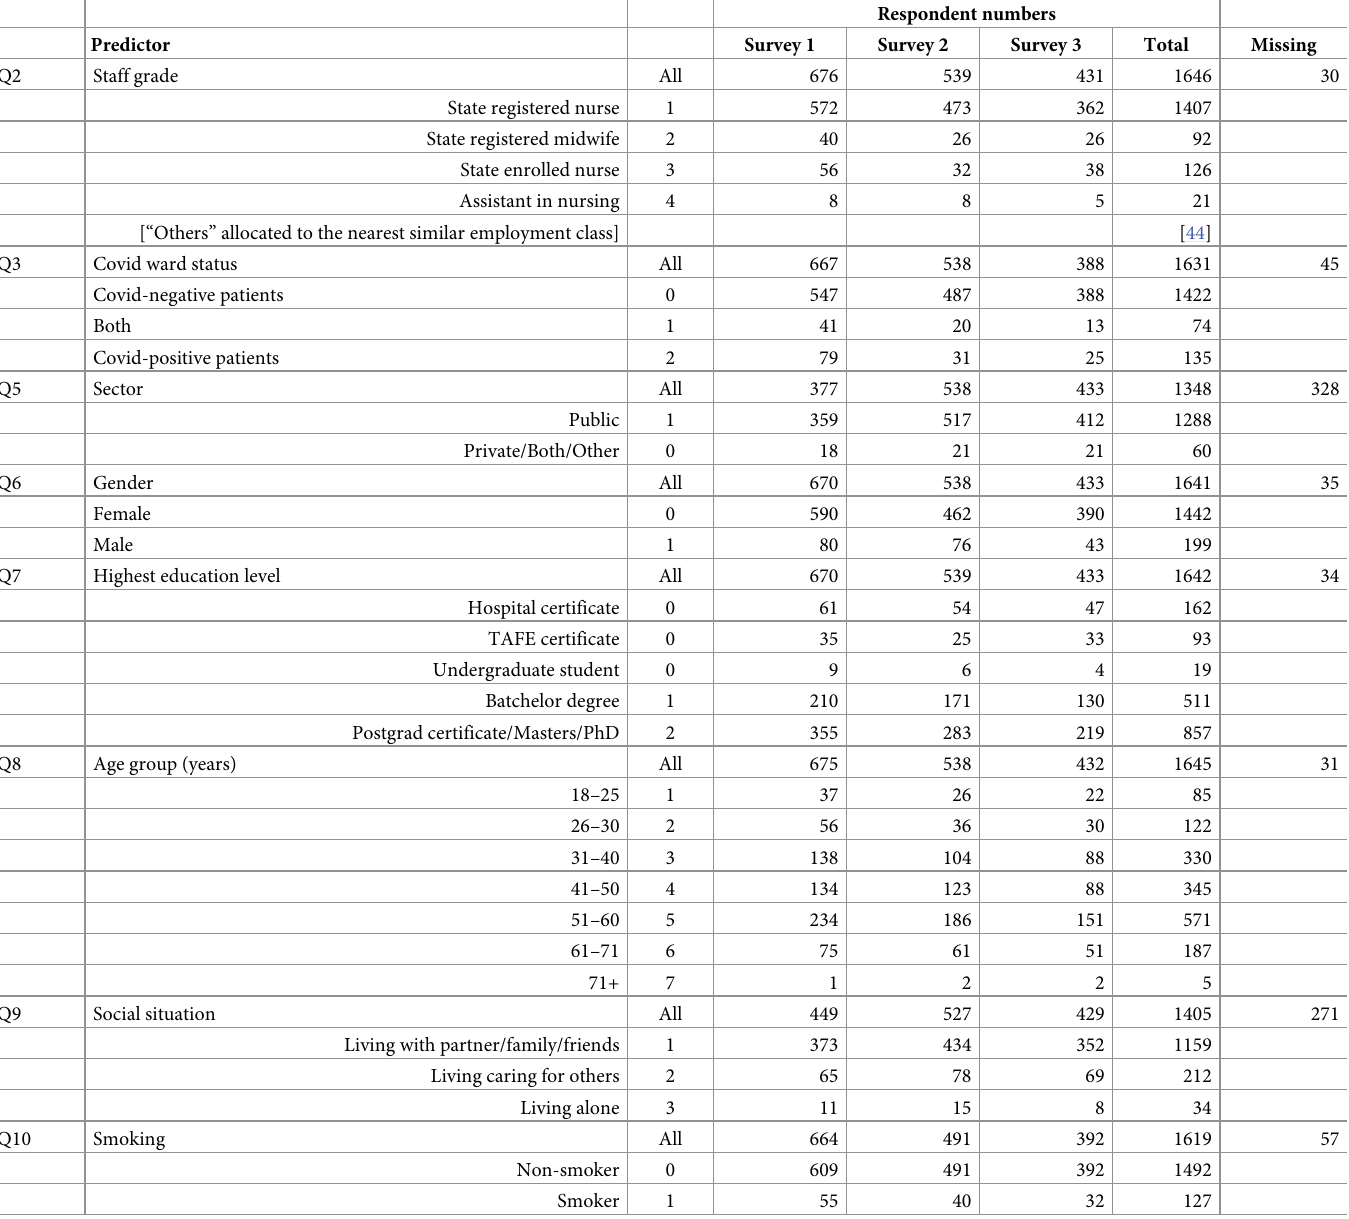
Table 1. Demographic characteristics of responders: Predictors, case numbers and missing